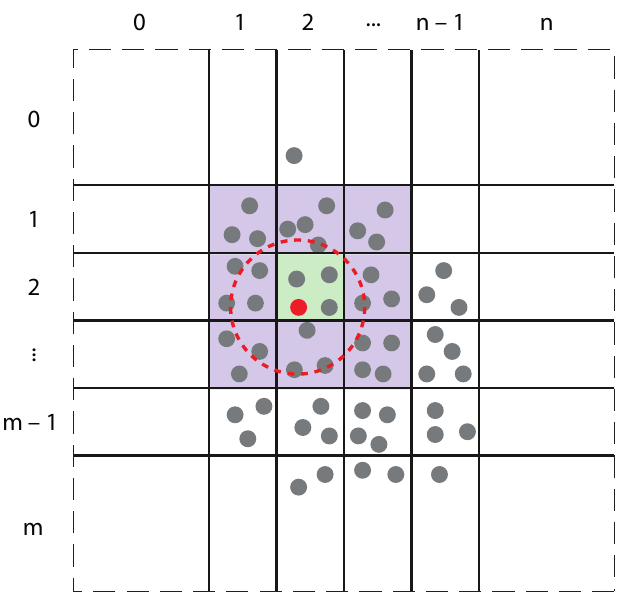
Figure 3. Gold substrate divided into cells. For the atom colored in red, the cut-off radius is indicated as a red, dashed circle, while its own cell is depicted in green and its neighboring cells in blue. Atoms whose positions are outside the cut-off sphere of the indicated atom are not taken into account in calculating the total force on the said atom. Note that the outermost cells have no boundary; this measure was taken to fit all of the 3D space (an atom may end up anywhere, after all) into a finite number of